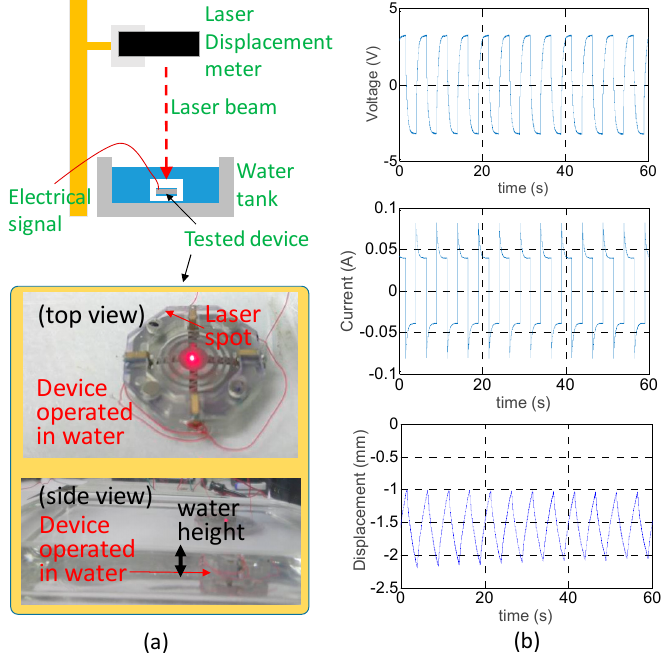
Figure 10. ( a ) Experimental setup for four IPMC actuator-constructed soft engine to stretch the zone plate in water. ( b ) Measured results of voltage drop across, current flowing through and displacement of the soft engine.